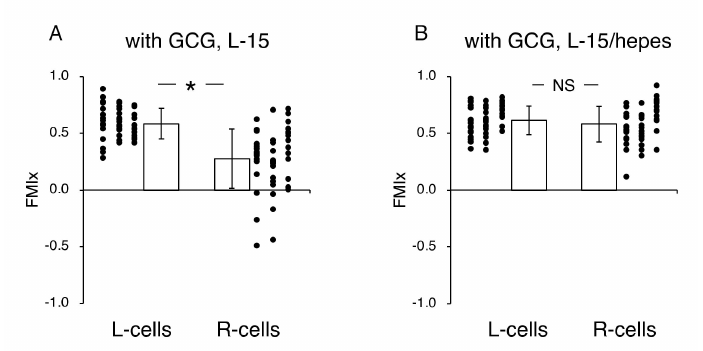
Figure 6. E ff ects of extracellular pH gradients on FMI x in cells underneath GCG. ( A ) In L-15 medium, the FMI x for the L-cells was significantly higher than that for the R-cells. This result is consistent with that in Figure 4B. ( B ) In L-15 / hepes medium in which extracellular pH gradients disappeared, the FMI x values for the L-cells and R-cells were not di ff erent ( p = 0.20), indicating that the directionality in cell migration also disappeared. Data were accumulated from five independent experiments in which 10 cells were sampled in each experiment. Error bars represent the SD. *, p < 0.05, as judged by Student’s t -test.